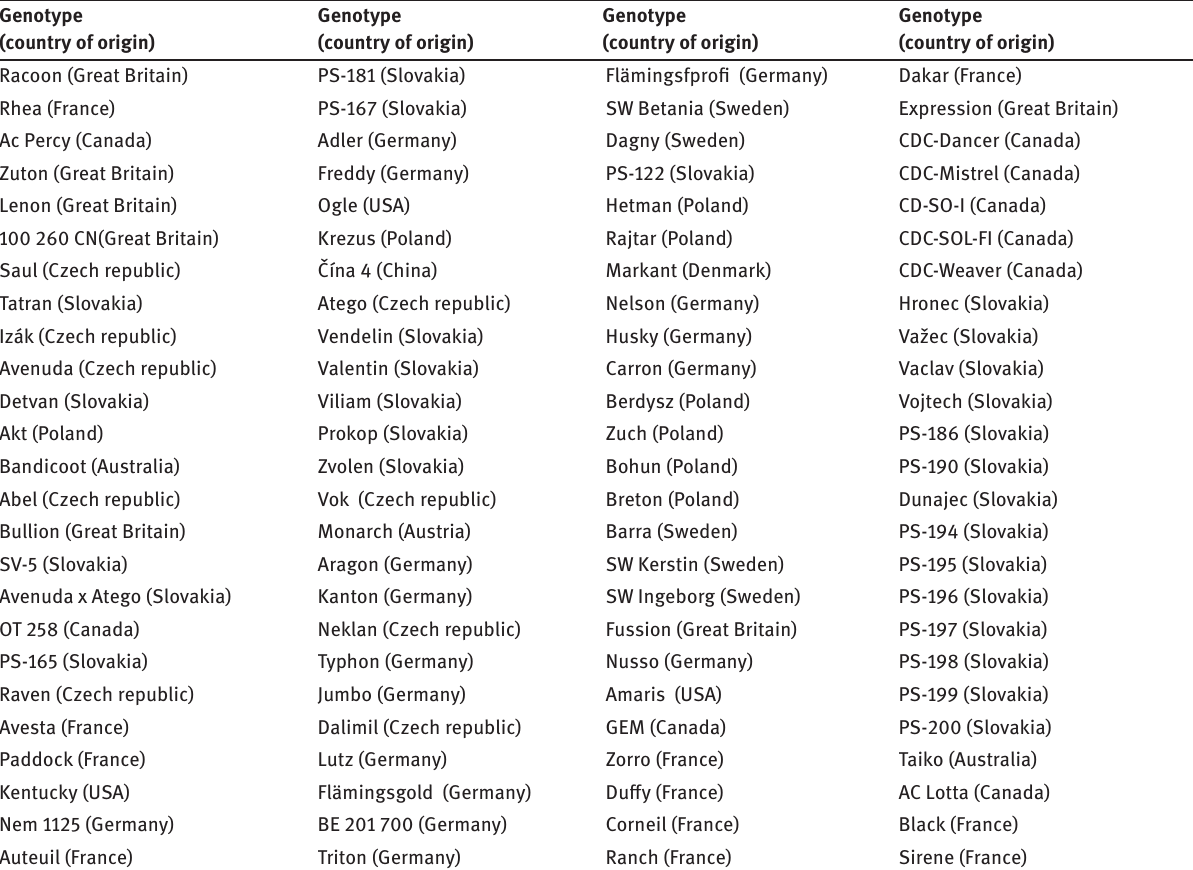
Table 1: The list and origin of analyzed genotypes of oats ( Avena sativa L.).